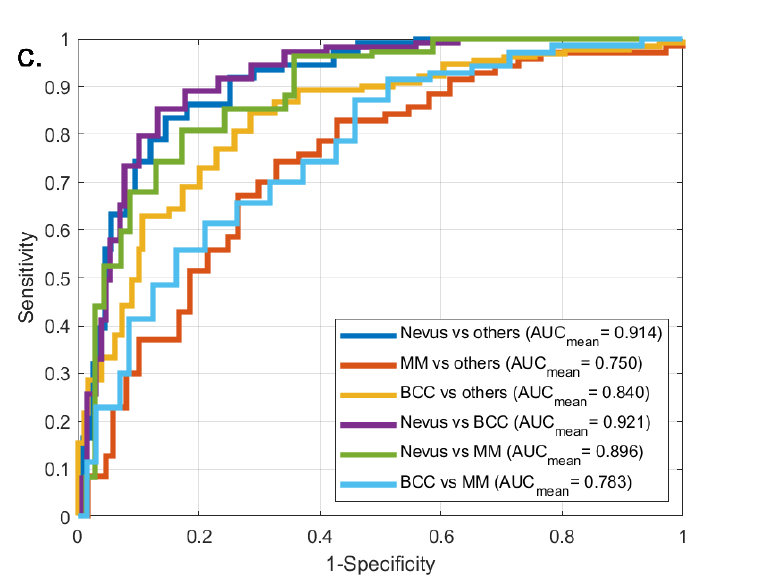
Figure 2. Receiver operating characteristic ( ROC ) curves using ( a ) freehand-seeding-based SA segmentation; ( b ) LAR-seeding-based SA segmentation; ( c ) FA segmentation and binary